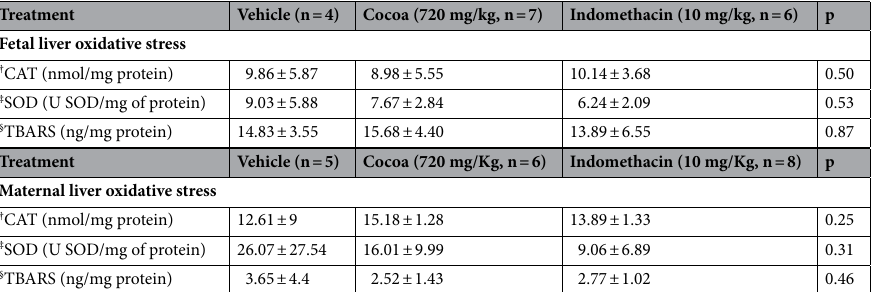
Table 1. Effect of Cocoa (720 mg/Kg; p.o.) and indomethacin (10 mg/Kg p.o.), on fetal liver oxidative stress and maternal. † Data are mean ± standard deviation range of † catalase activity (CAT), ‡ superoxide dismutase activity (SOD). § Thiobarbituric reactive substances (TBARS) of cocoa compared with vehicle-indomethacin group (analysis was made using one-way ANOVA, p >